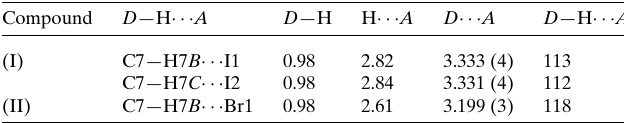
Table 2 Short contacts and contributions (%) to the Hirshfeld surface for DINT, DCNT and